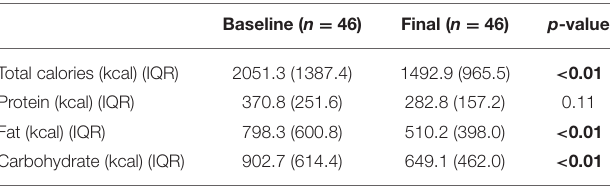
TABLE 3 | Patient characteristics and clinical outcomes comparing study participants who lost at least 5% of their body weight to those that did not.